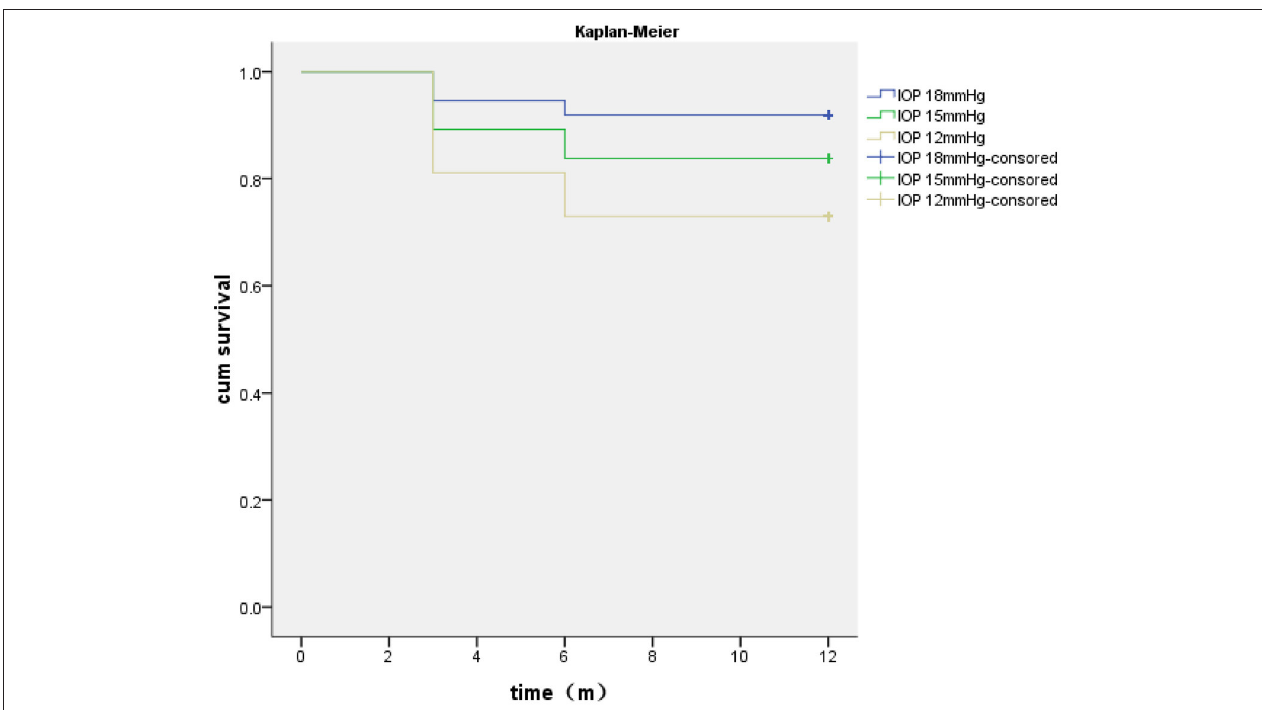
FIGURE 4 | Kaplan–Meier analysis of the surgical complete success rates based on the different intraocular pressure (IOP)